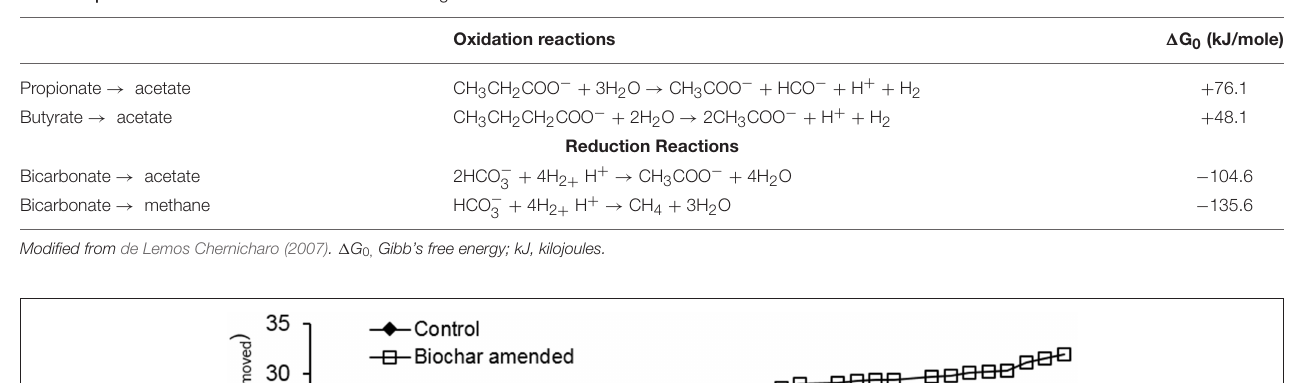
TABLE 5 | Oxidation-reduction reactions in anaerobic digestion.